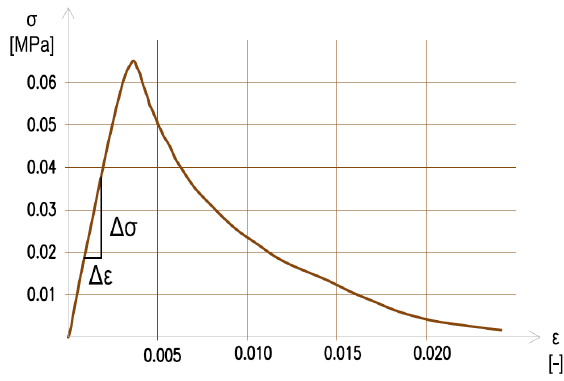
Figure 8. Principle of determinig of modulus of elascity from σ - ε